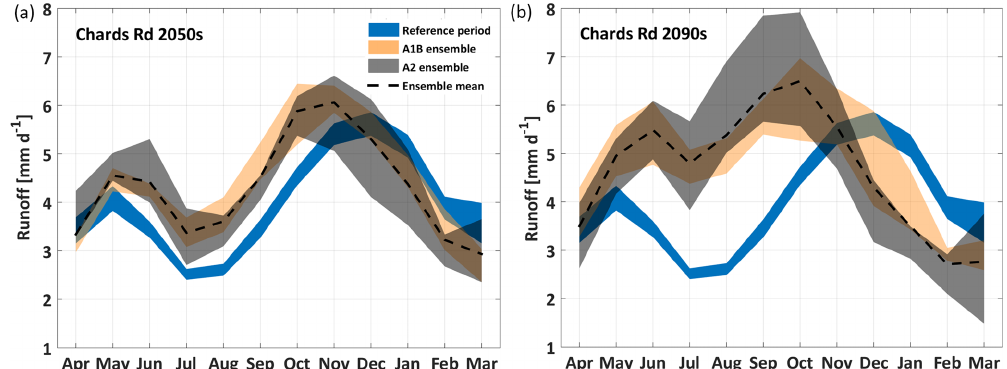
Figure 8. Mean daily modelled runoff (orange envelope = A1B and grey envelope = A2) at Chards Rd during (a) the 2050s and (b) 2090s is compared with the historic simulations (blue). All simulations are based on the QM-Anderson